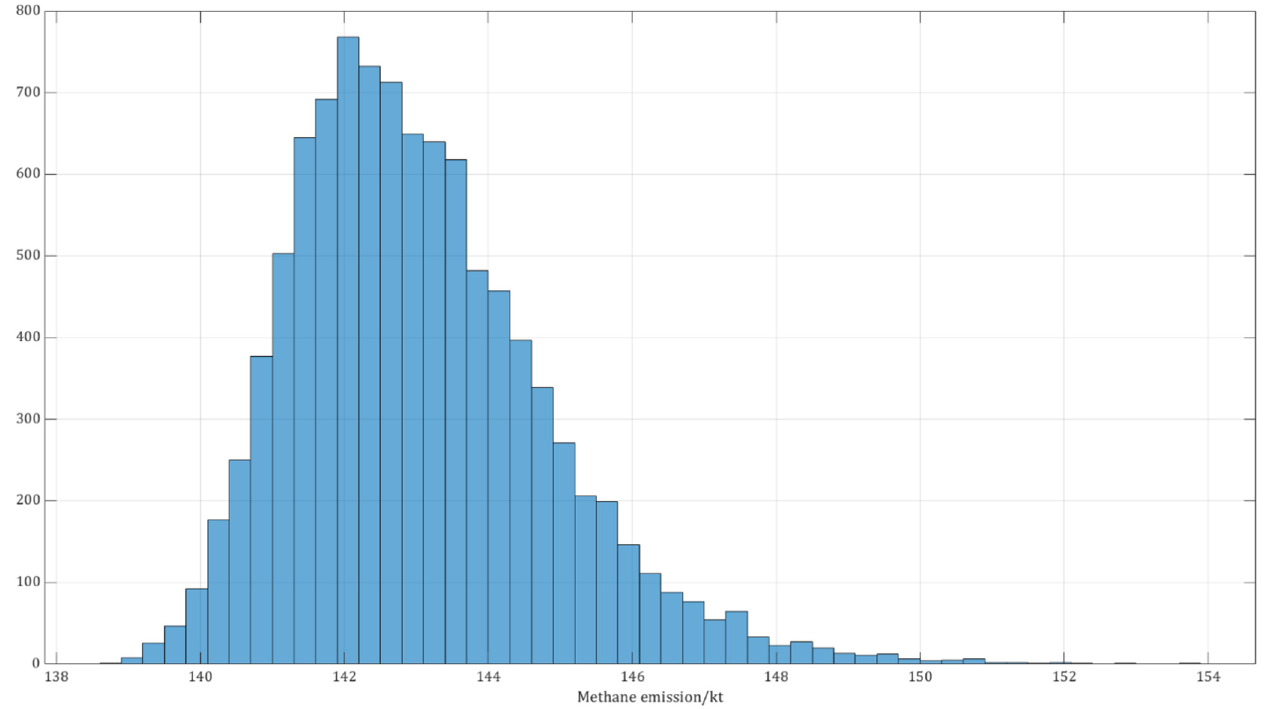
Figure 6. Histogram of total methane emission in 2018.